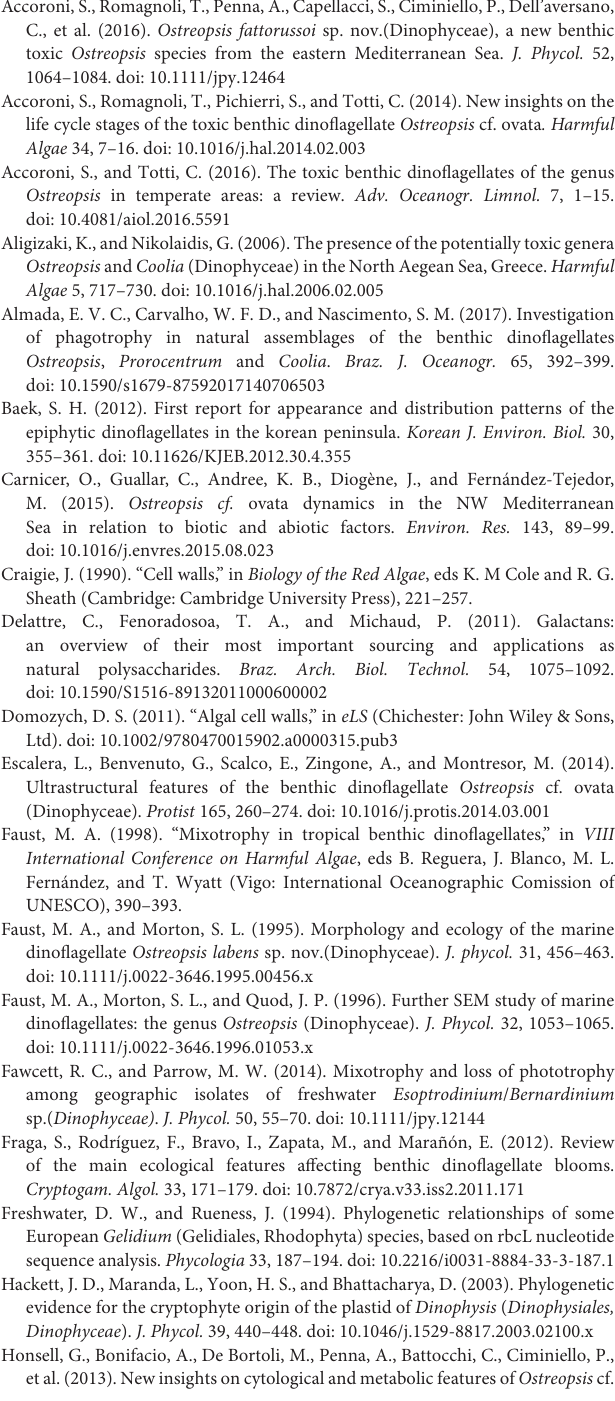
Figure S1 | Phylogenetic tree based on rbc L amino acid sequences from Rhodophyta, Haptophyta, Stramenopiles, and Cryptophyta. Sequences from the ingested food particles of Ostreopsis cells isolated from this study are indicated in bold face. Bootstrap values ( > 70%) from maximum likelihood